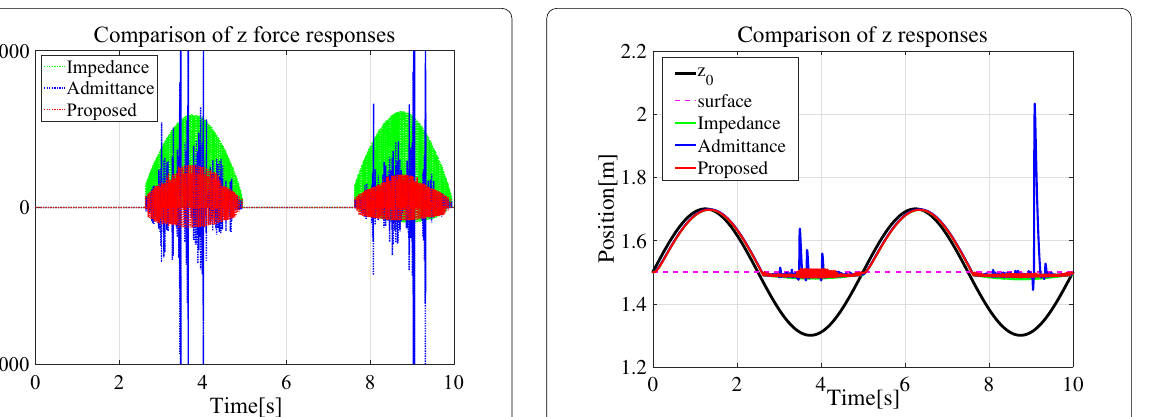
Fig. 13 Transient response of the z coordinate of endpoint Fig. 14 Time variation of the reaction force in the z direction for